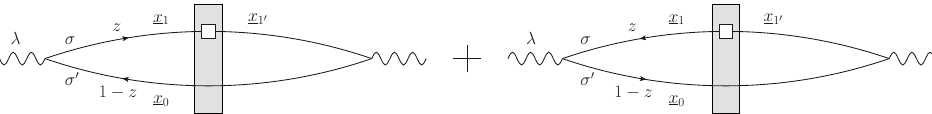
Figure 2. Diagrams needed for the calculation of the g 1 structure function in the dipole picture of DIS. The proton shock wave is denoted by the shaded rectangle, while the white box denotes the sub-eikonal interaction with the